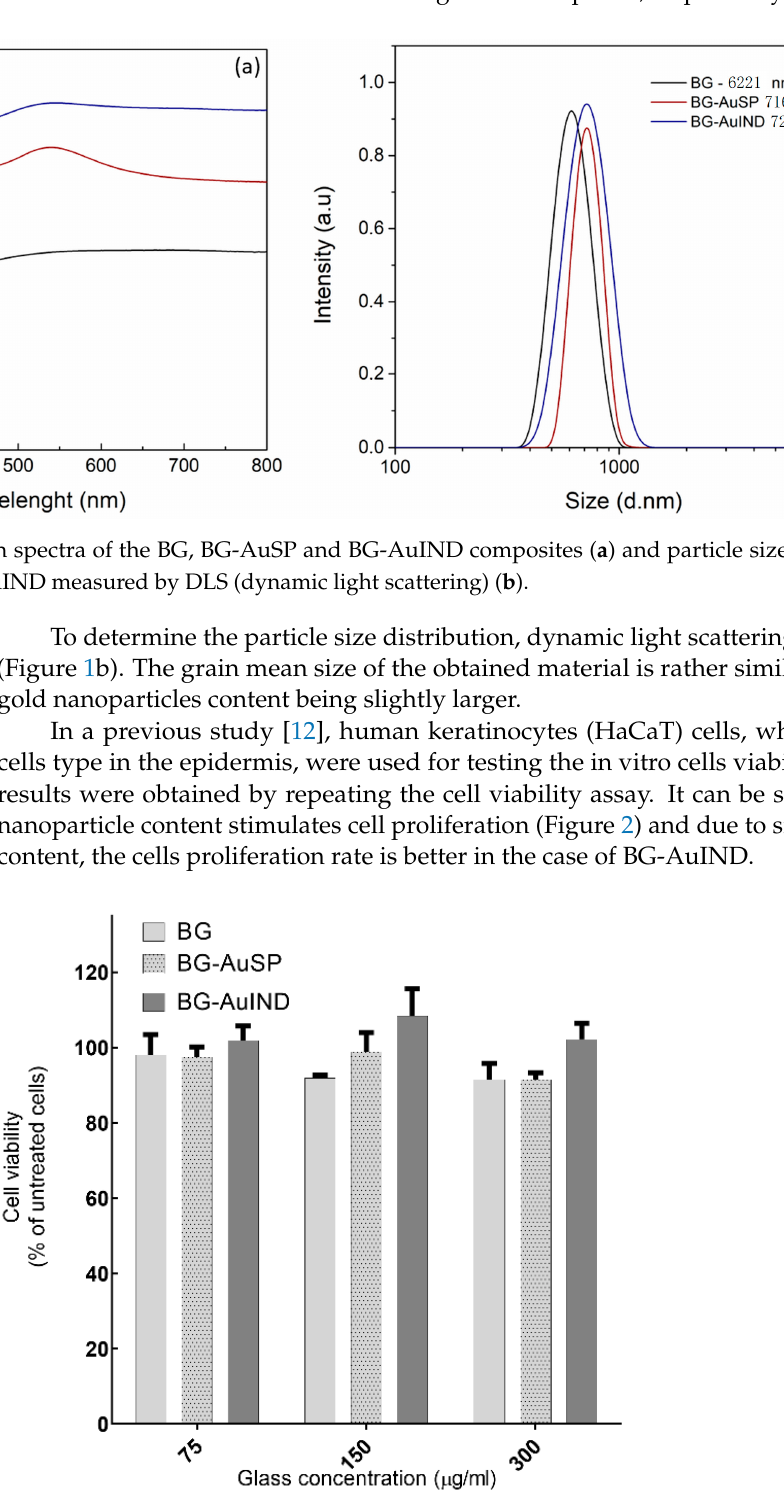
Figure 2. Viability of HaCaT cells after 24 h interaction with different concentrations of BG, BG-AuSP and BG-AuIND ( p < 0.05).